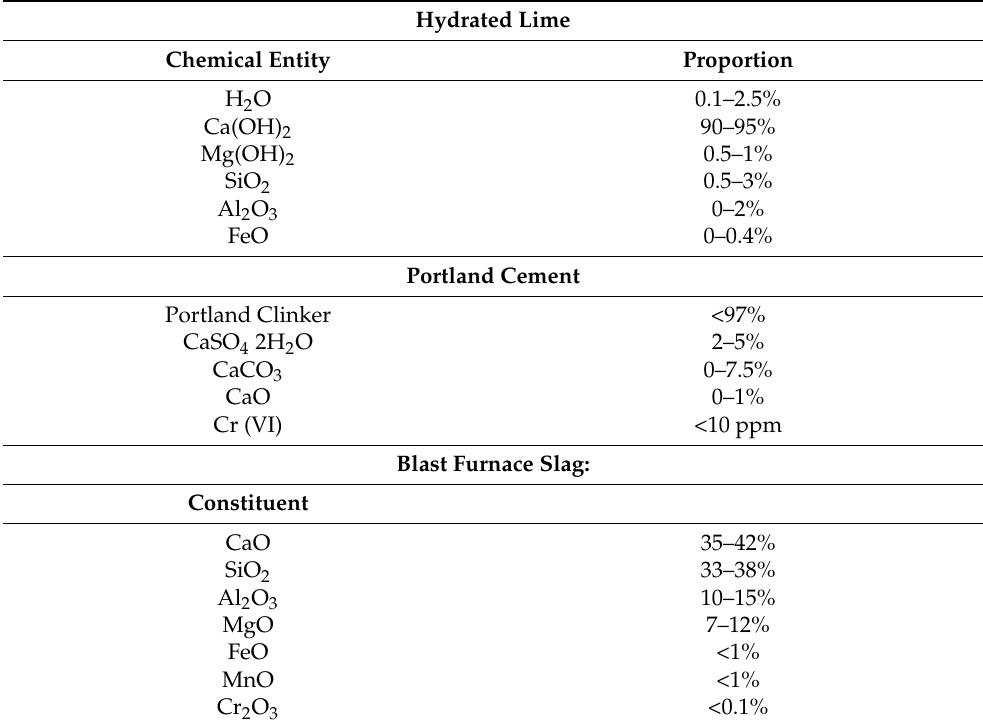
Table 2. Chemical composition of hydrated lime and Portland cement (data from [26]) and blast furnace slag chemical composition (data from